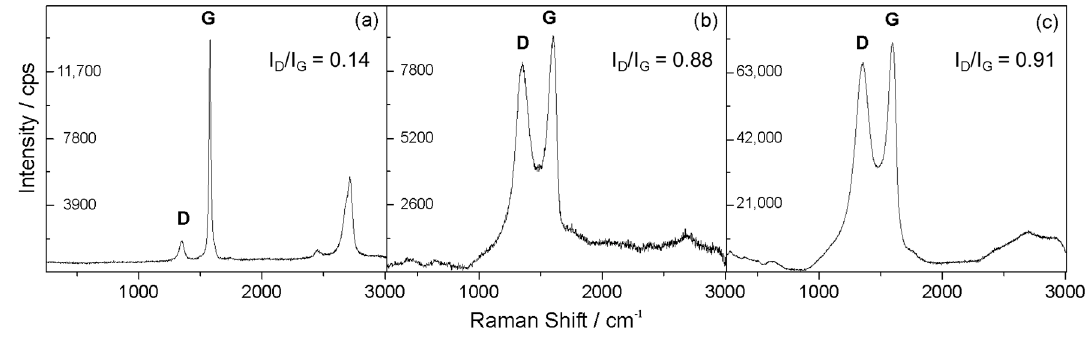
Figure 3. Raman spectra of untreated natural graphite ( a ); graphitic oxide ( b ); and graphene nanosheets ( c ).